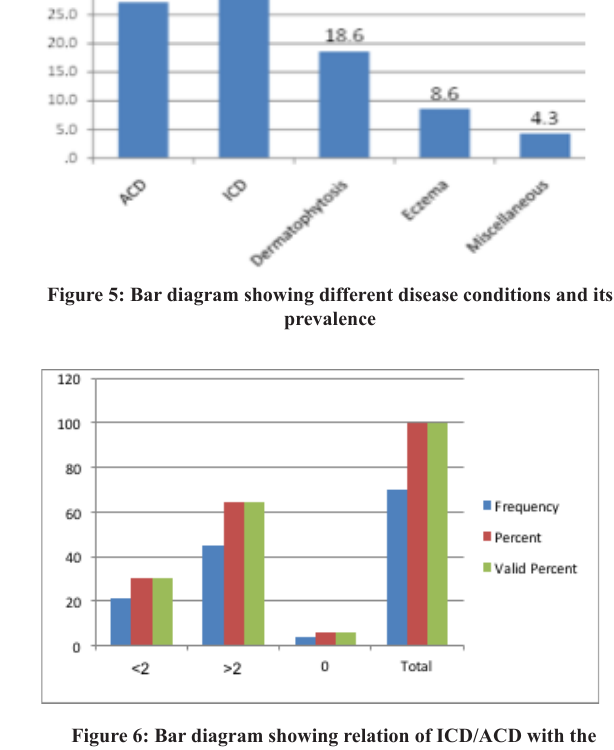
Figure 6: Bar diagram showing relation of ICD/ACD with the exposure of the patient with water. (<2 hours and > 2